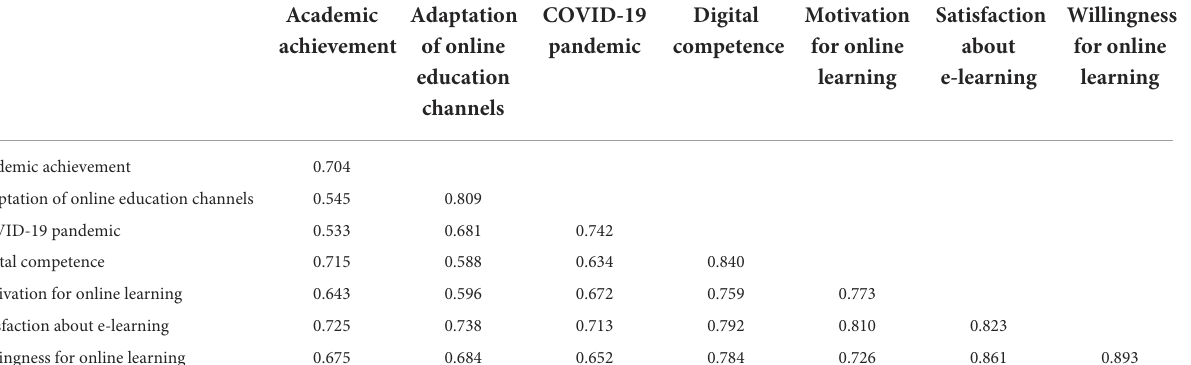
TABLE 3 Discriminant validity assessment results